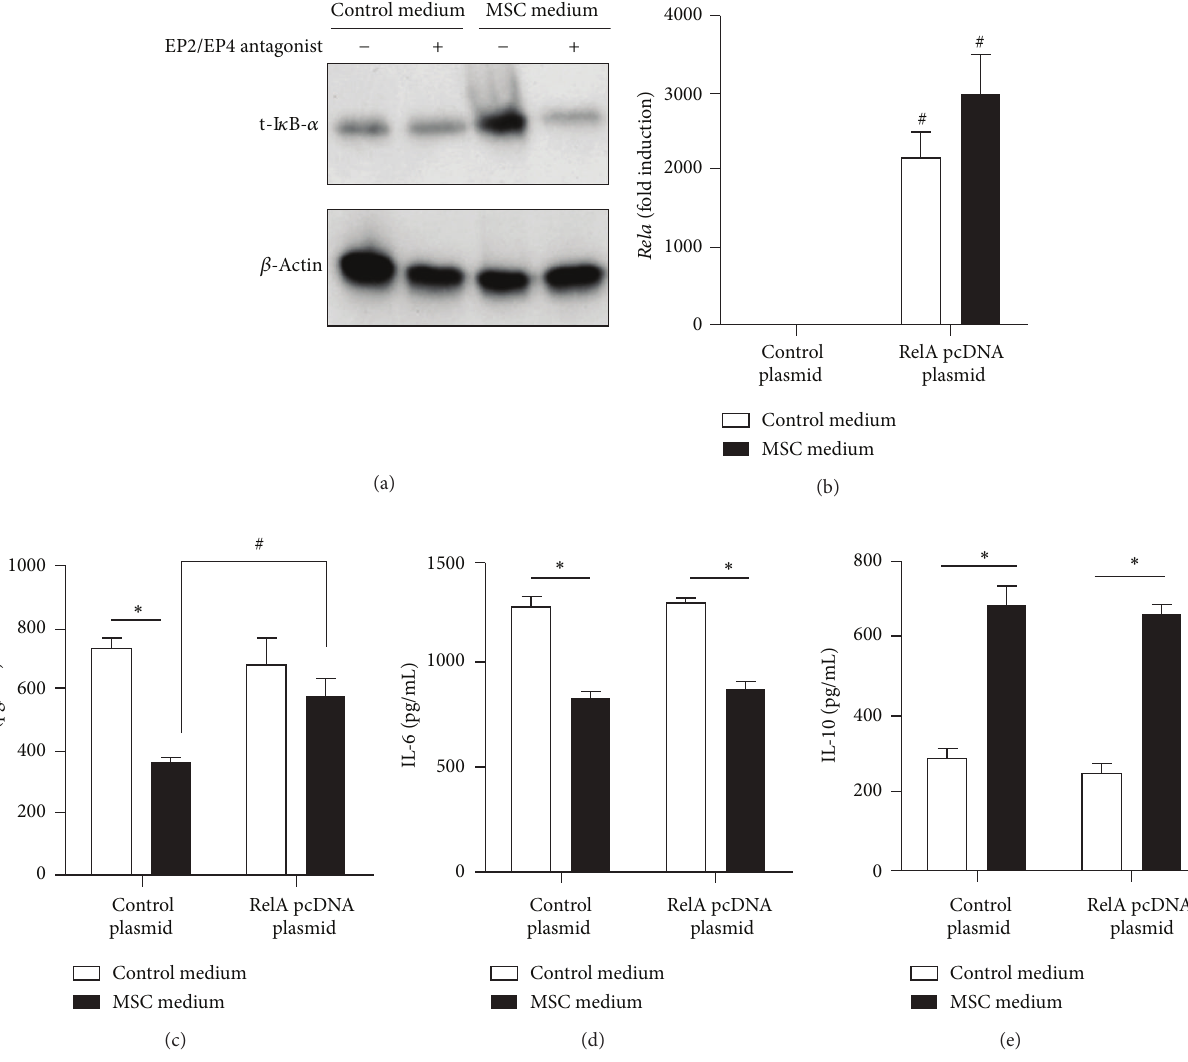
Figure 6: NF- 𝜅 B signaling is partially responsible for the modulated expression of TNF- 𝛼 , but not that of IL-6 or IL-10, in BMDMs preincubated in MSC-conditioned medium and then subjected to R848 stimulation. (a) BMDMs were incubated in MSC-conditioned medium or control medium with or without a cocktail consisting of an EP2 antagonist (AH6809, 10 𝜇 M) and EP4 antagonist (GW 627368X, 10 𝜇 M). DMSO was used as the vehicle. After 1h, R848 (TLR7/8 ligand, 10 𝜇 g/mL) was added, and BMDMs were incubated for an additional 1h. The level of total I 𝜅 B- 𝛼 was determined by immunoblotting. Beta-actin was used as a loading control. Results are representative of 3 independent experiments. (b–e) BMDMs were transfected with RelA cFlag pcDNA3 plasmid or pcDNA3.1 plasmid (as a control) using FuGENE6 Transfection Reagent. After 24 h, the cells were incubated for 1h in either MSC-conditioned medium or control medium, after which they were stimulated with TLR7/8 ligand (R848) or vehicle for 24 h in either MSC-conditioned medium or control medium. The level of Rela mRNA was determined using qRT-PCR (b). Data are expressed as the fold increase over the level of Rela in control plasmid-transfected cells cultured in control medium without R848 stimulation (mean ± SEM). # 𝑃 < 0.05 , compared to the control plasmid-transfected cells. The levels of TNF- 𝛼 (c), IL-6 (d), and IL-10 (e) in the supernatant were determined using ELISA. ∗ 𝑃 < 0.05 , compared to the control medium group. # 𝑃 < 0.05 , compared to the control plasmid-transfected cells. Data are expressed as the mean ± SEM. 𝑛 = 3 in each group. Results are representative of 3 independent